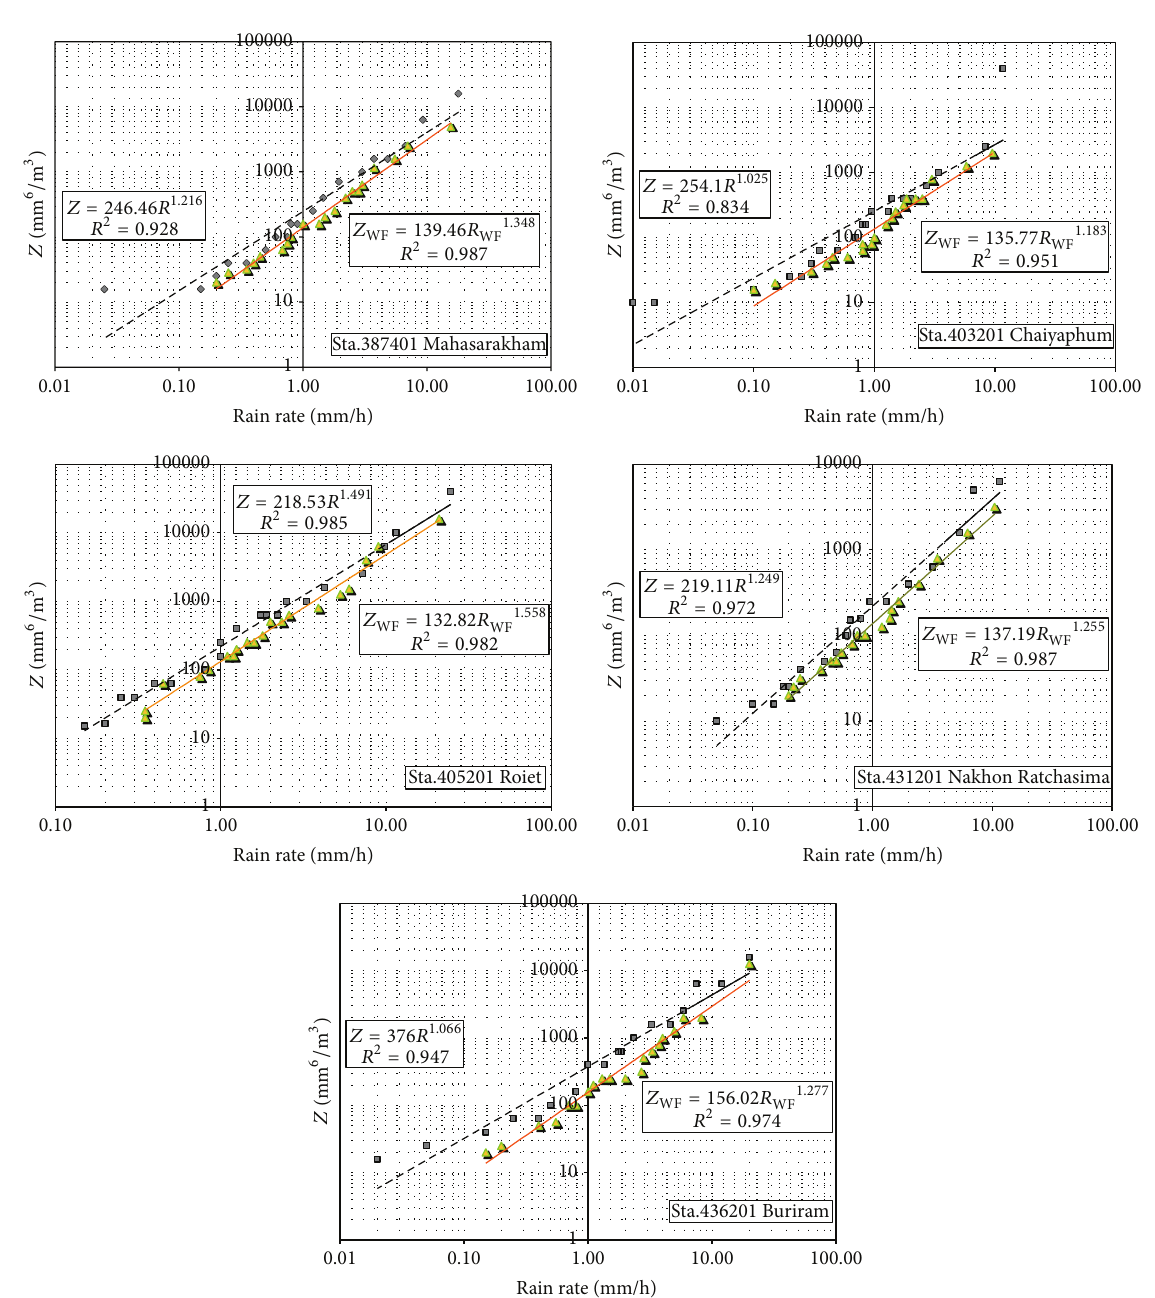
Figure 7: Scatter plot of 𝑍 - 𝑅 pairs for conventional practice and 𝑍